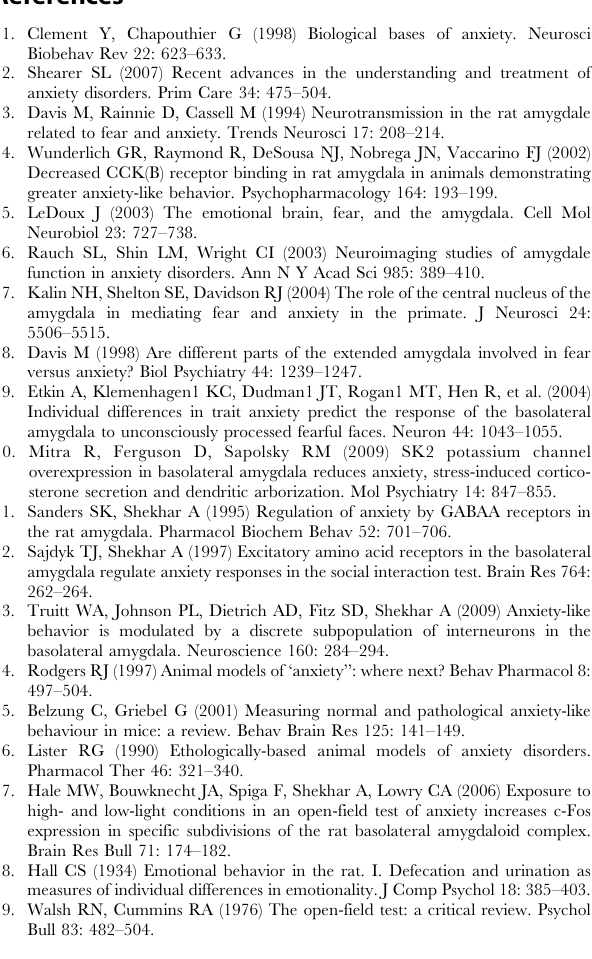
Figure S1 Multi-channel in vivo recording from the